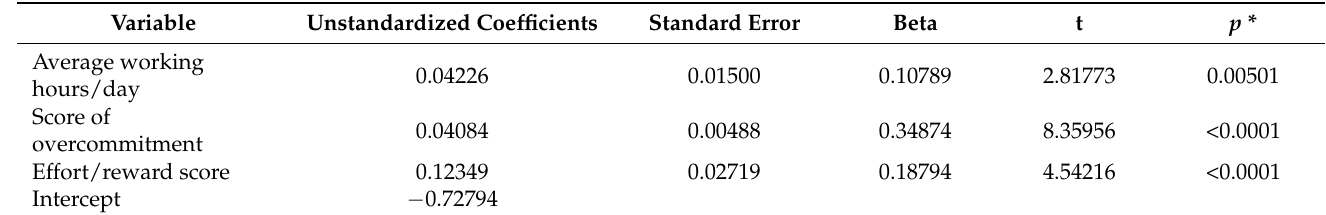
Table 6. Relation between the variables and high exhaustion score in